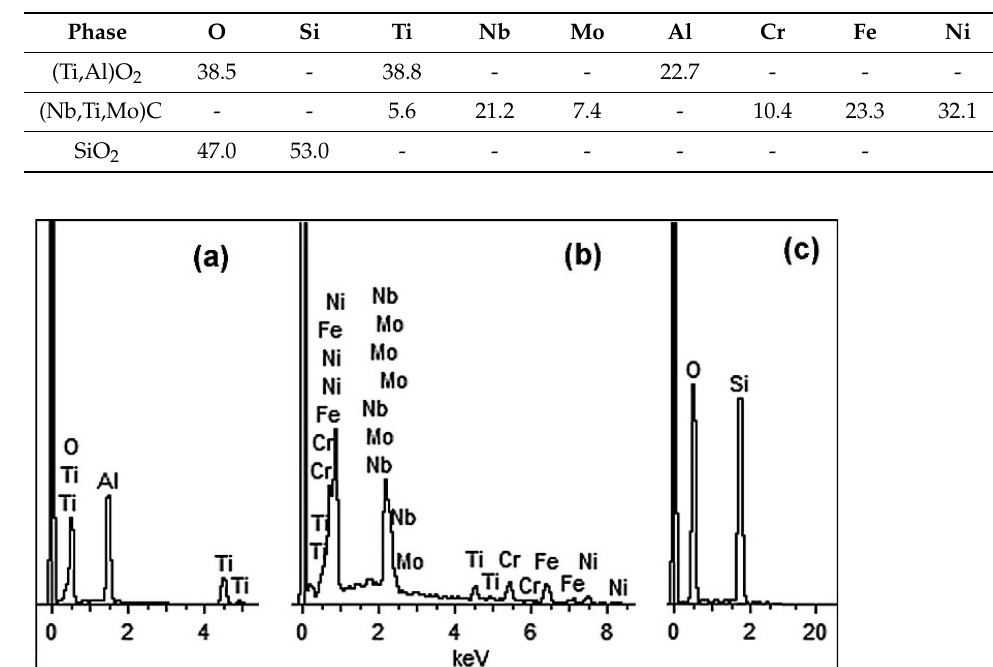
Figure 2. EDXspectra of ( a ) oxide (Ti,Al)O 2 , ( b ) carbide (Nb,Mo,Ti)C and ( c ) oxide SiO 2 in LPBF 316L.